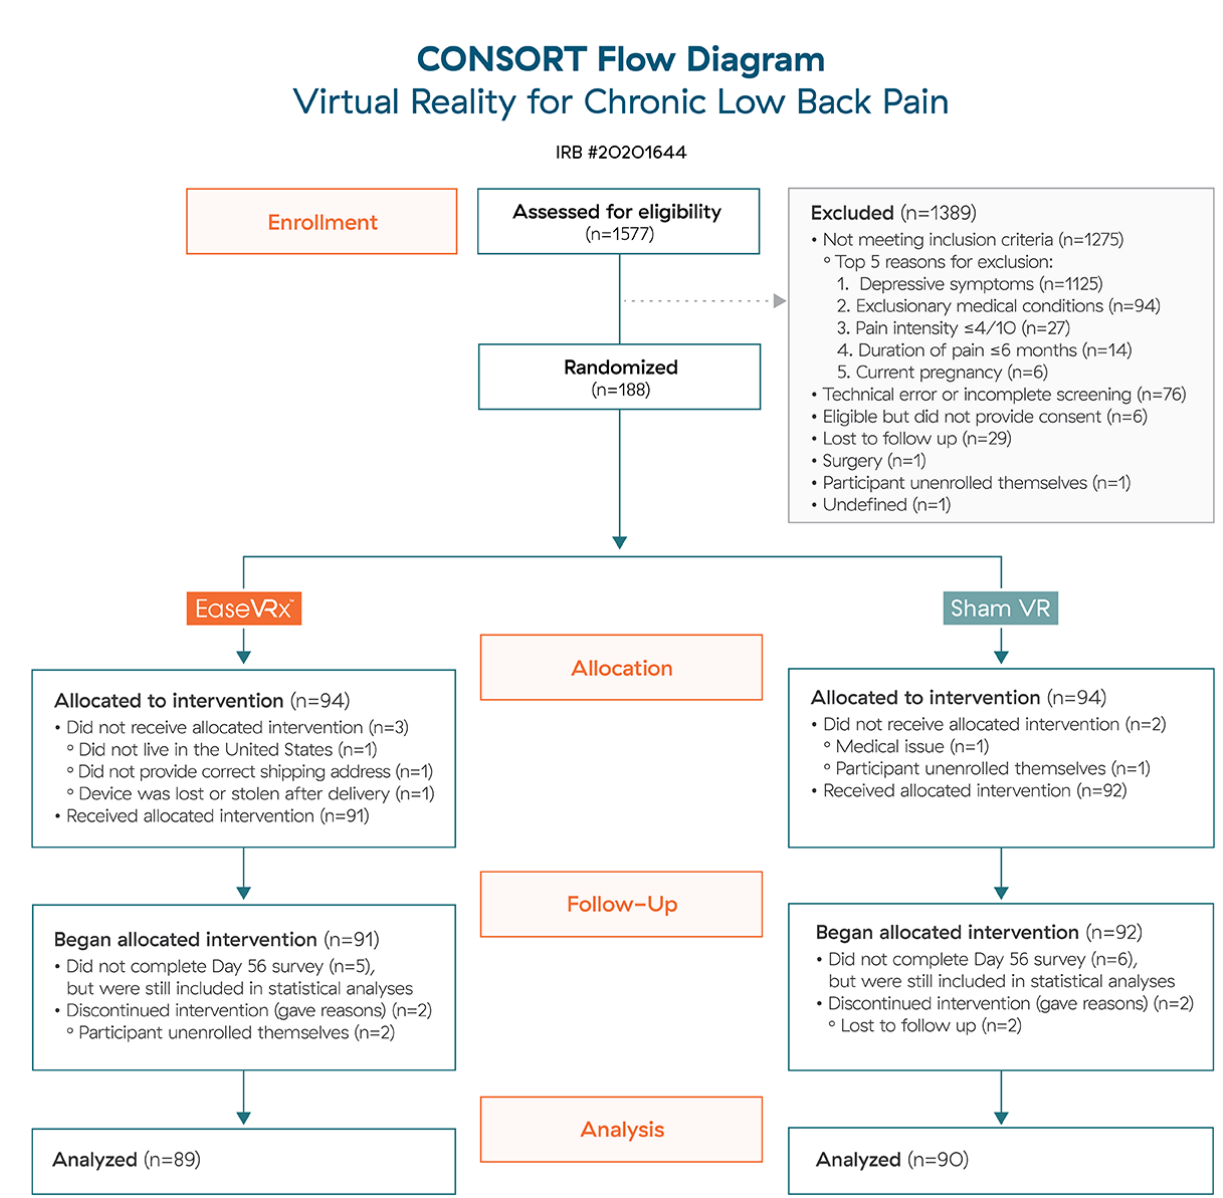
Figure 3. CONSORT Flow